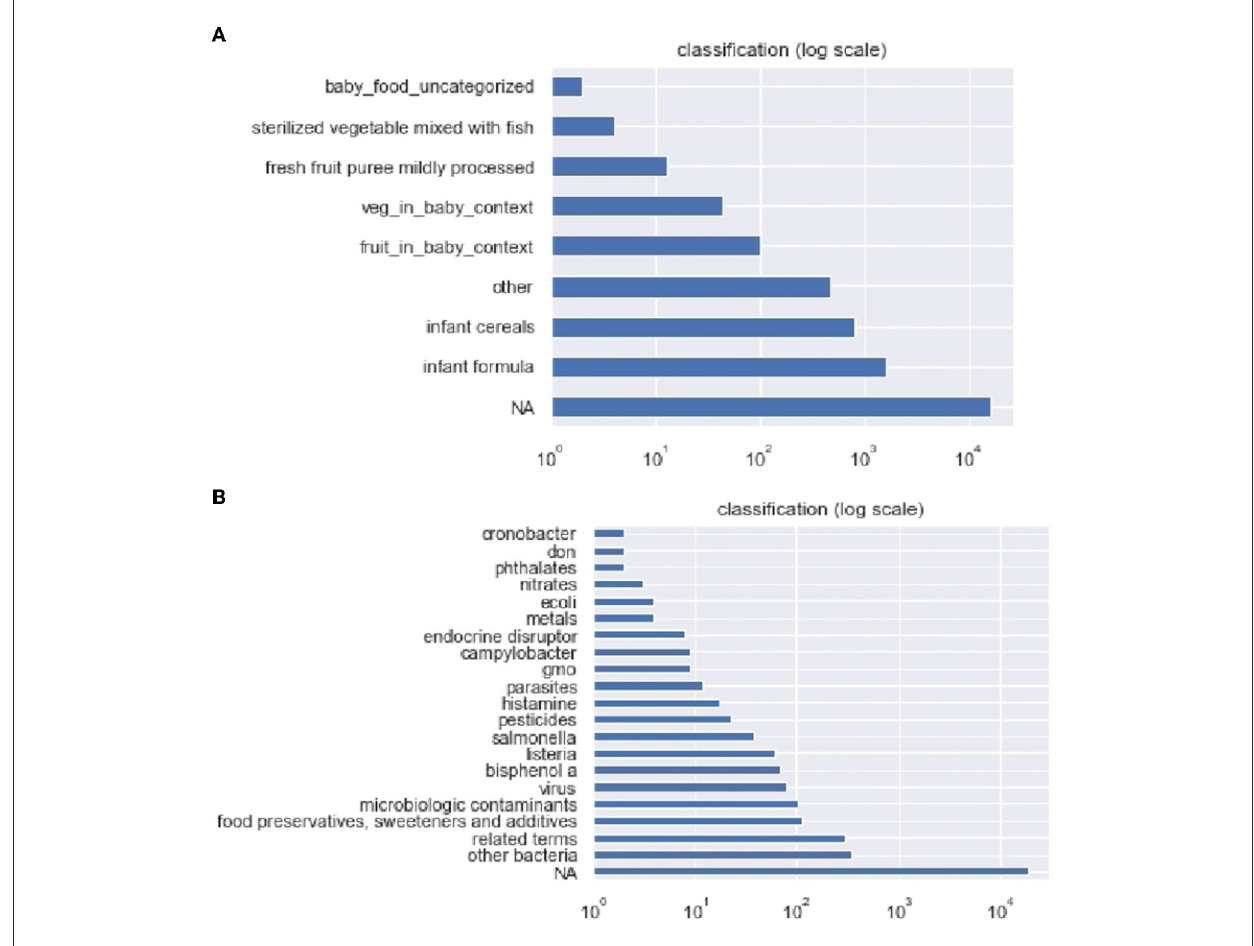
FIGURE2 Number of posts obtained in each category (A) for food products and (B) for hazards.